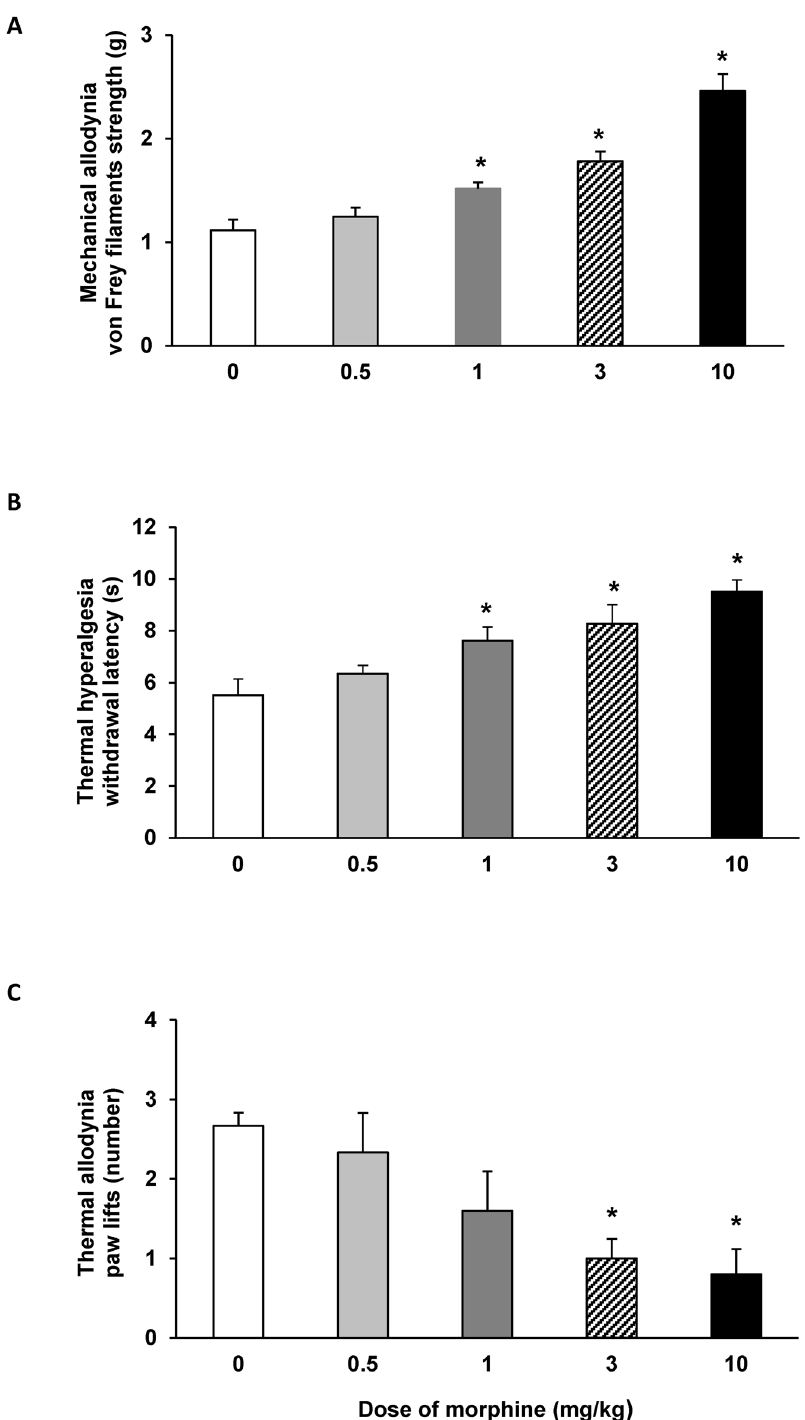
Fig 2. Effects of the subcutaneous administration of morphine on the mechanical allodynia, thermal hyperalgesia and thermal allodynia induced by the administration of STZ. Mechanical antiallodynic (A), thermal antihyperalgesic (B) and thermal antiallodynic (C) effects produced by the subcutaneous administration of different doses of morphine in STZ-injected mice. Data are expressed as von Frey filaments strength (g) for mechanical allodynia, withdrawal latency (s) for thermal hyperalgesia and paw lifts (number) for thermal allodynia. For each test, * denotes significant differences versus saline treated mice (0 mg/kg) (p